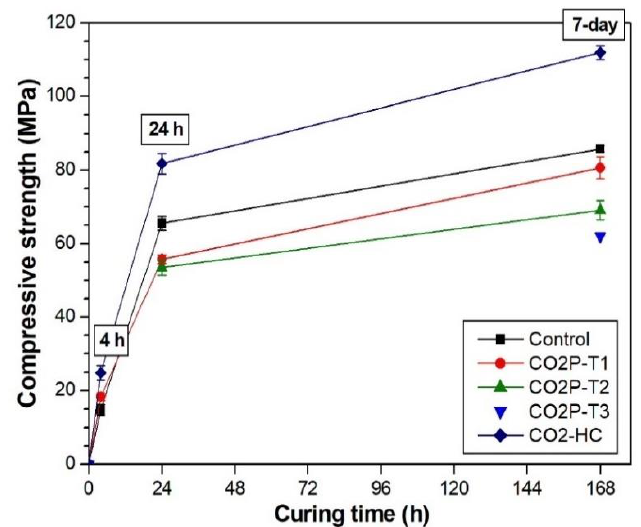
Figure 4. Compressive strength developments of paste samples cured under different curing conditions with curing time.